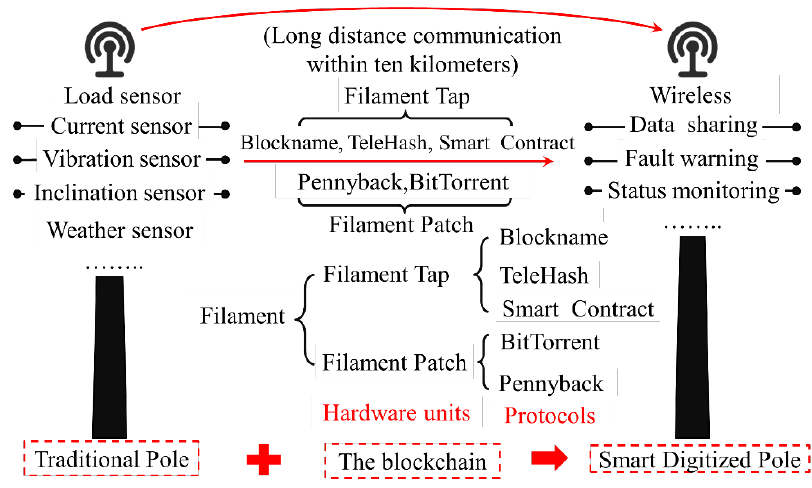
Figure 11. Application of the blockchain in the communication poles of the Filament project.